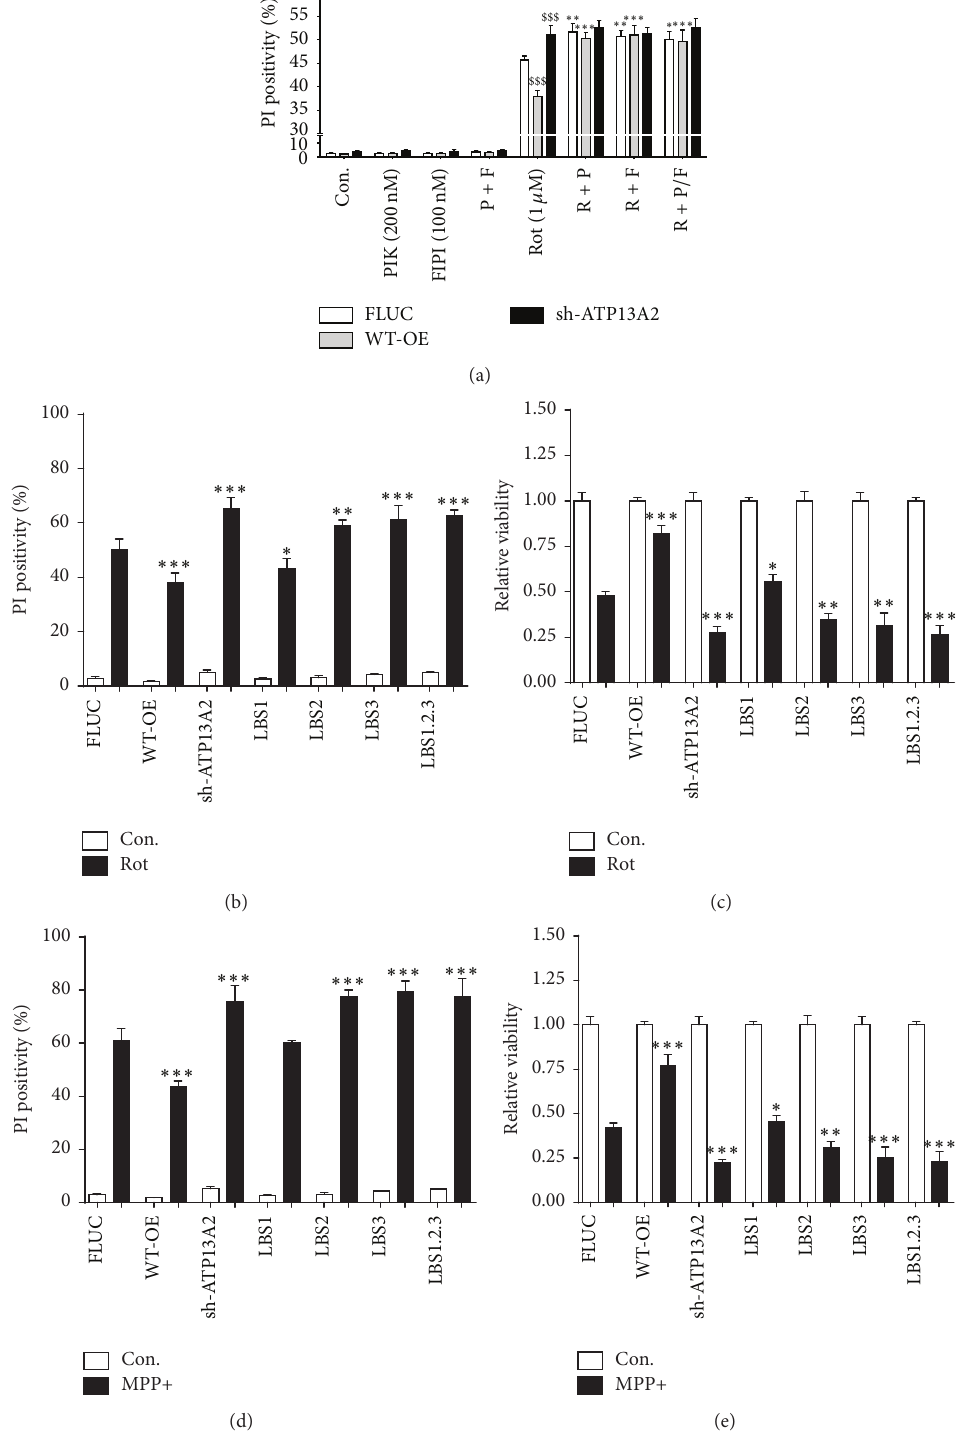
Figure 2: LBS mutations prevent ATP13A2-mediated cytoprotection. (a) ATP13A2’s protective response at 24 h exposure to rotenone (Rot, 1 𝜇 M) and the effect of pharmacological inhibition of PIKfyve lipid kinase with YM-201636 (PIK or P, 200 nM) and inhibition of PLD with FIPI (F, 100 nM) on cell death were assessed via a propidium iodide (PI) based assay. $ statistical differences between FLUC and WT-OE/sh- ATP13A2, ∗ statistical differences within cell line following treatment with inhibitor (1 mark, 𝑃 < 0.05 ; 2 marks, 𝑃 < 0.01 ; 3 marks, 𝑃 < 0.001 ) (ANOVA with Bonferroni post hoc test). ((b)–(e)) Stable cell lines were exposed to 1 𝜇 M rotenone ((b)-(c)) or 50 𝜇 M MPP+ ((d)-(e)) for 24 h and cell death was assessed by PI stained flow cytometry, whereas cell viability was assayed by the MUH protocol. Data are the mean of 3 independent experiments ± SD. ∗ statistical differences between FLUC and WT-OE/sh-ATP13A2/LBS1/LBS2/LBS3/LBS1.2.3 (1 mark, 𝑃 < 0.05 ; 2 marks, 𝑃 < 0.01 ; 3 marks, 𝑃 < 0.001 ) (ANOVA with Bonferroni post hoc